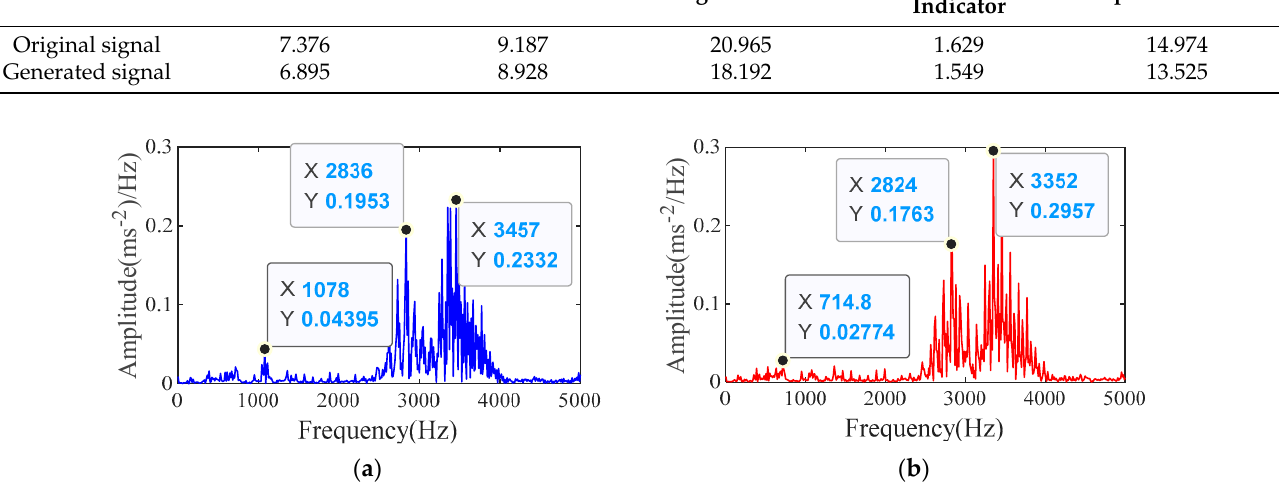
Figure 12. Contrast the original signal spectrum with the generated signal spectrum: ( a ) original signal; ( b ) generated signal.